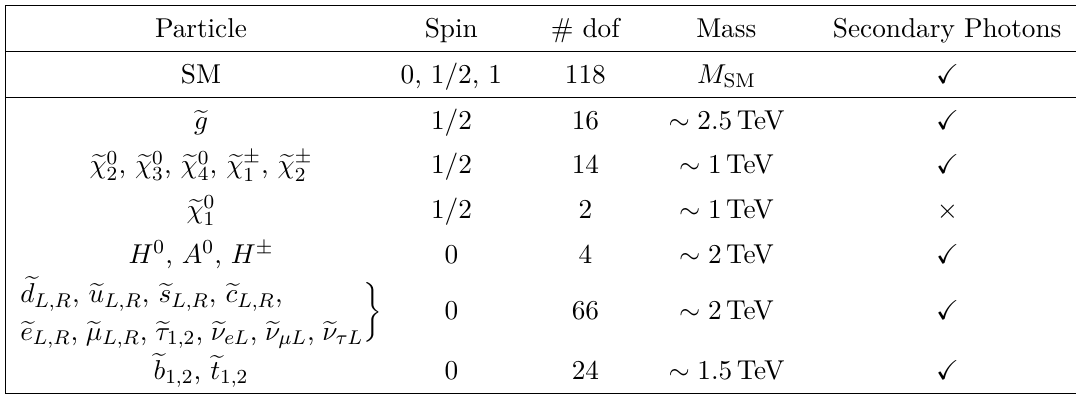
Table 1 . Particle content of the benchmark MSSM Model with masses less than ∼ 10 7 GeV and spin less than 3 / 2 , see